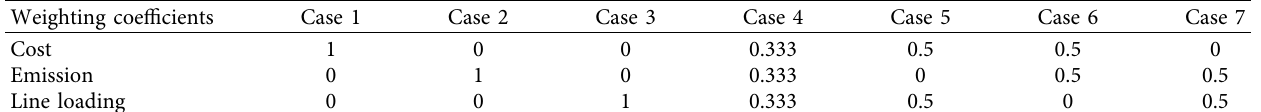
Table 3: Weighting coefcients of objective functions for Group A.